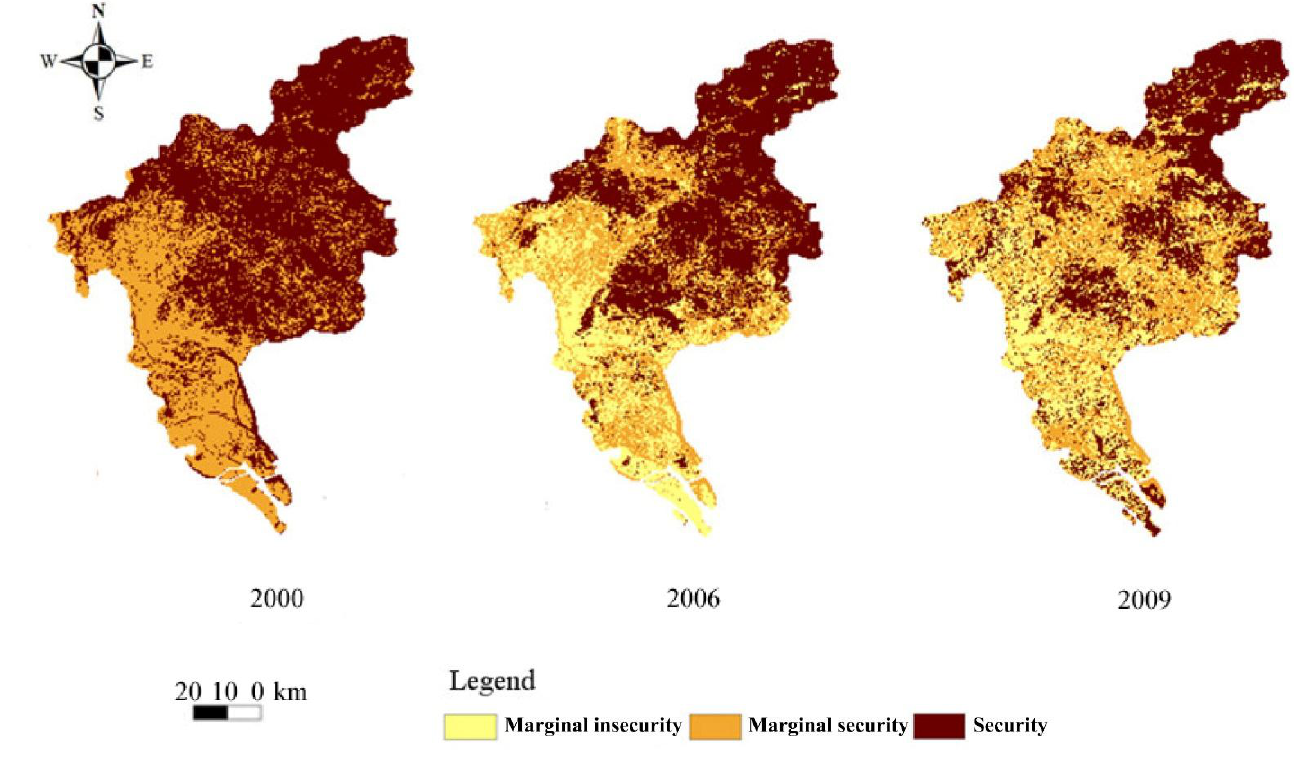
Figure 6. Spatial differentiation of unit comprehensive